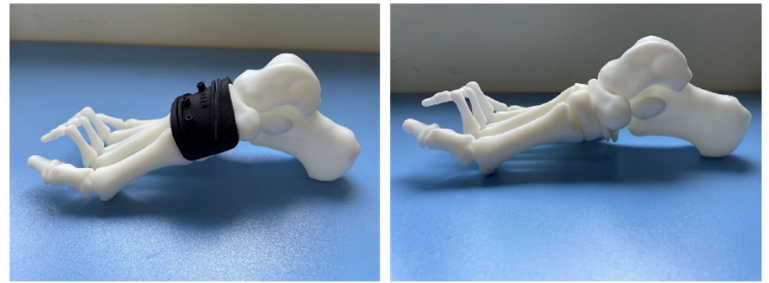
Figure 18. Three-dimensional printed midfoot osteotomy guide to assist cavus foot